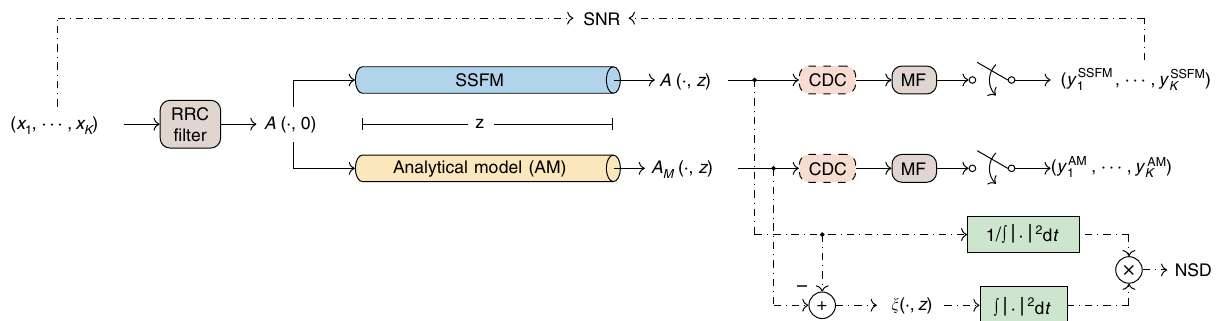
Fig. 2 Schematic of NSD and SNR calculations. The transmitted symbols ( x 1 ; ¼ ; x K ) are fi ltered by a root-raised-cosine (RRC) fi lter, originating the input signal A ( ⋅ , 0). This input signal is processed either by the SSFM or by an analytical model (AM), resulting in the outputs A ( ⋅ , z ) and A M ( ⋅ , z ), respectively. The NSD is obtained from the SSFM output A ( ⋅ , z ) and a model output A M ( ⋅ , z ), whereas the SNR is obtained from the transmitted symbols ( x 1 ; ¼ ; x K ) and with the received symbols ( y 1 ; ¼ ; y K ) from the SSFM or from an analytical model. To obtain the received symbols, the output waveforms are submitted to an optional chromatic dispersion compensation (CDC) block, followed by a matched fi lter (MF)